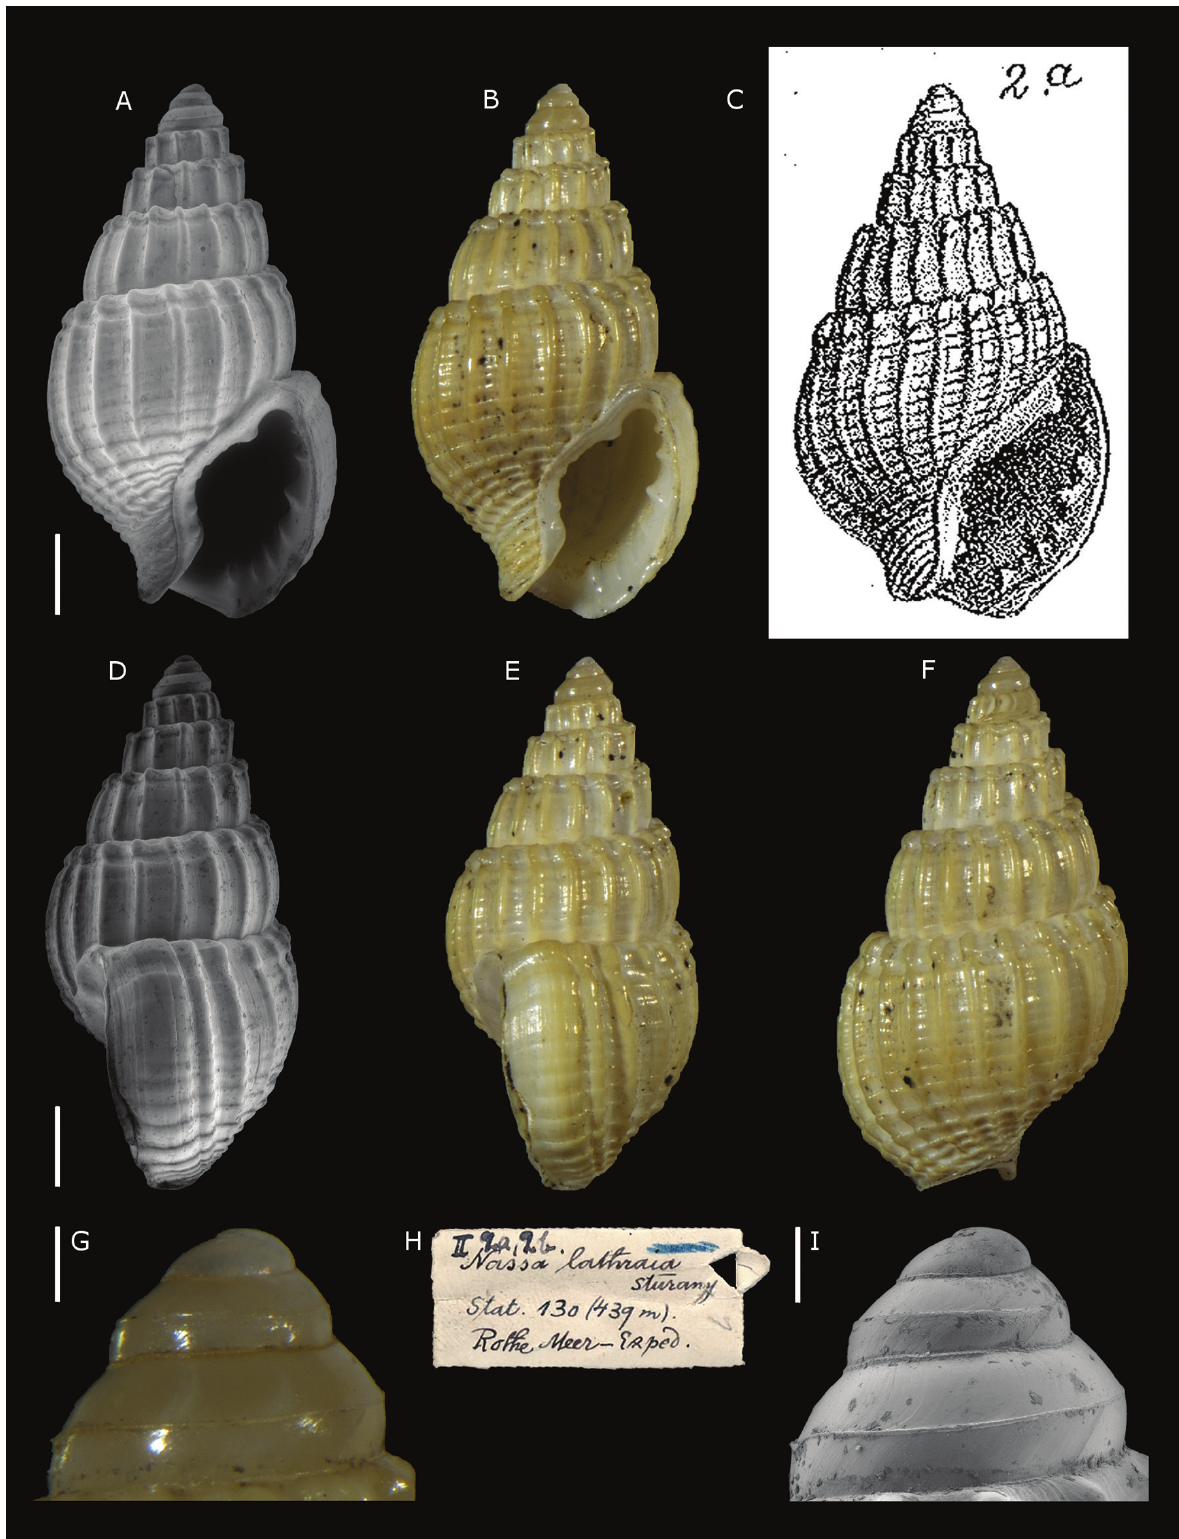
Figure 12. Nassa lathraia Sturany, 1900, Station 130 (Al Qunfudhah, Saudi Arabia, Red Sea). A–B , D–G , I . Figured syntype, NHMW 84203: front ( A–B ), right side ( D–E ), back ( F ), protoconch ( G, I ). C . Original figure by Sturany (1903). H . Original label of figured syntype. Scale bars: A–B , D–F : 1 mm, G , I : 0.2